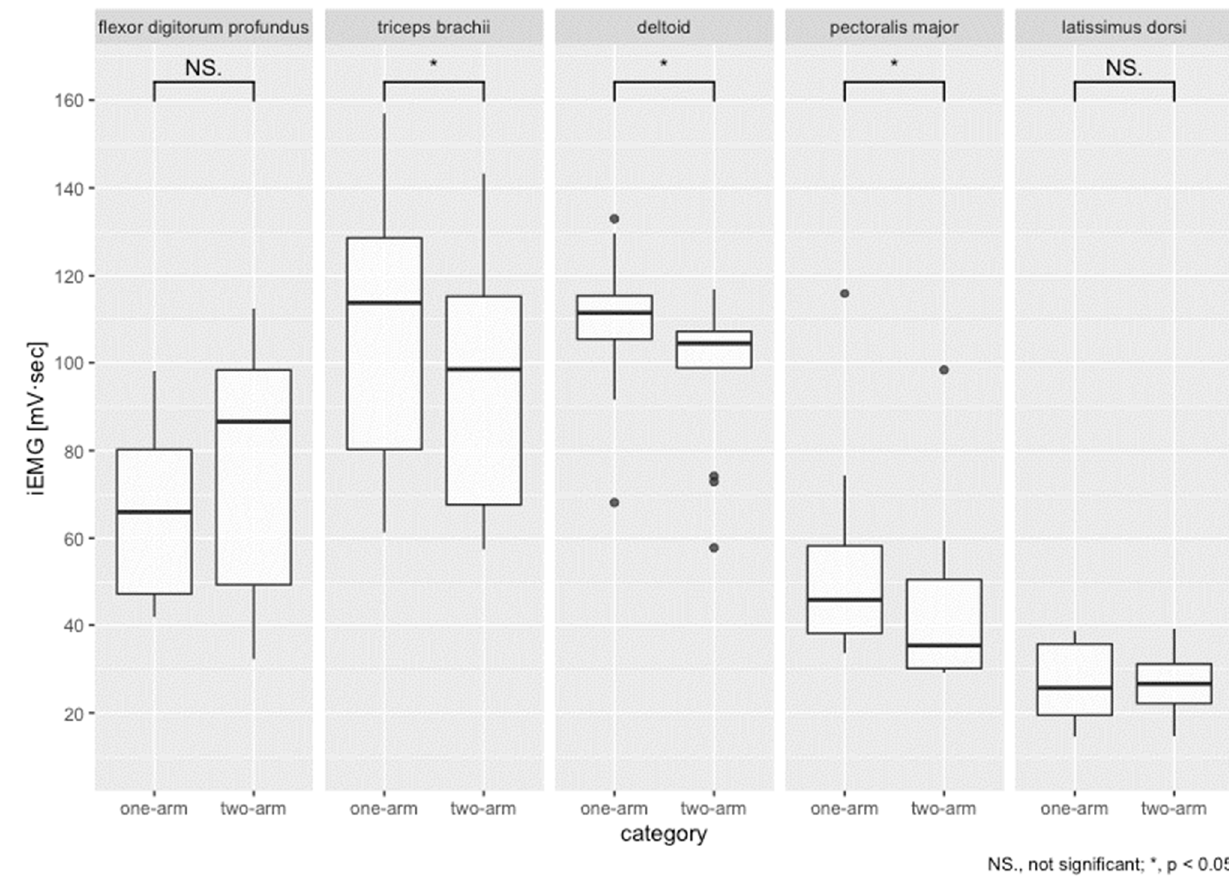
Figure 6. Distribution of iEMG results obtained at each muscle site with one-arm and two-arm driving.